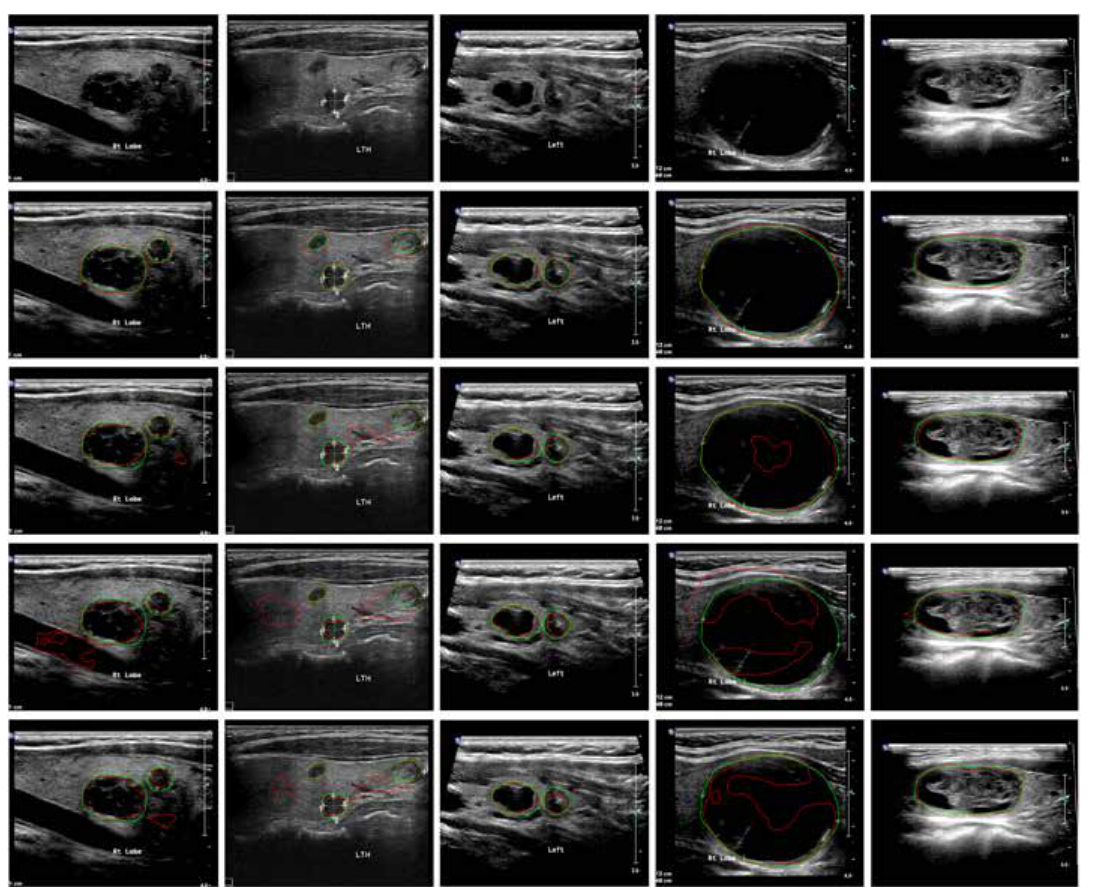
Figure 9 Cases of segmentation for thyroid nodule images by our pre-trained convolutional neural network (PCNN) and the other convolutional neural network methods. The original images are shown in the first row. The ground truths are shown in green. The red contours of images in the second, third, fourth and fifth rows show the segmentation results by our PCNN, residual convolutional network, very deep convolutional network and Zeiler convolutional network, respectively.